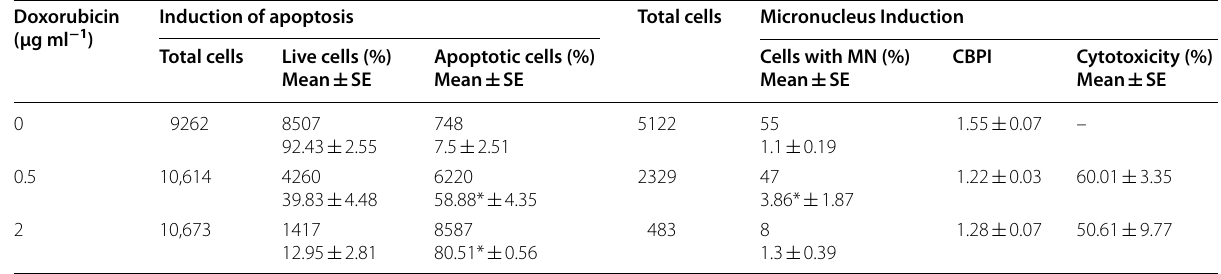
MN micronucleus, CPBI Cytokinesis Block Proliferation Index, SE standard error * p 0.0001 in comparison with control (G-test) ≤